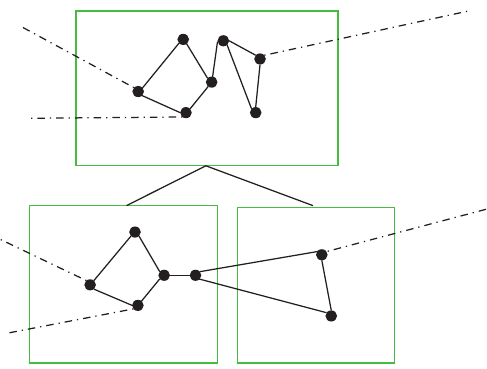
Figure 10: An obtained